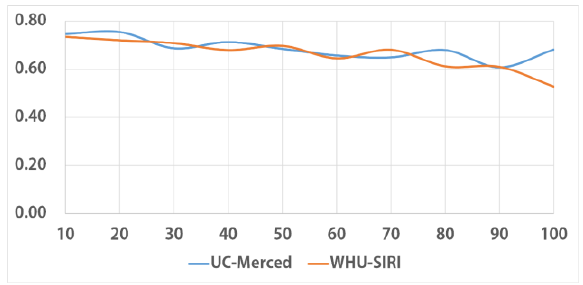
Figure 8. Accuracy assessment (y-axis) of urban land-use classification using different sampling windows (x-axis) during prediction